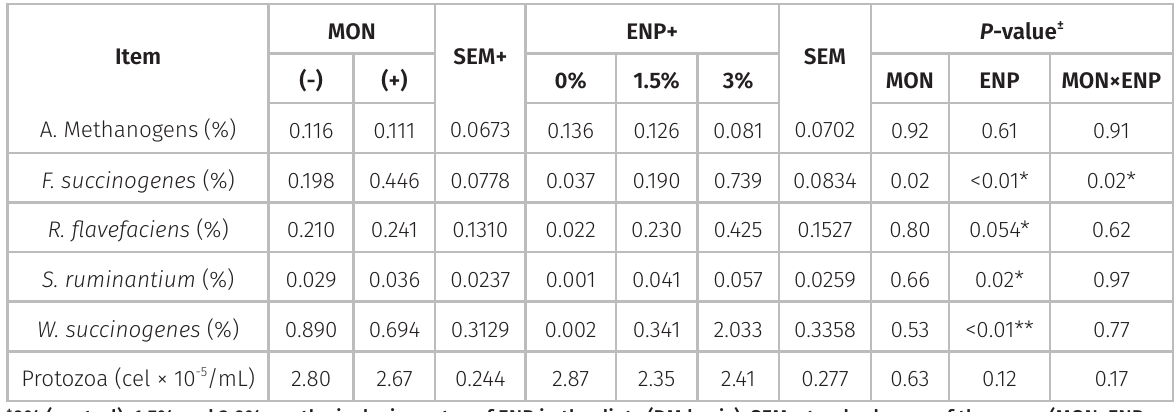
Table V. Effect of inclusion encapsulated nitrate product (ENP) in diets without (-) or with (+) monensin (MON) on the abundance relative of microbial populations in the rúmen (% of the total quantity of bacterial 16S rDNA) and